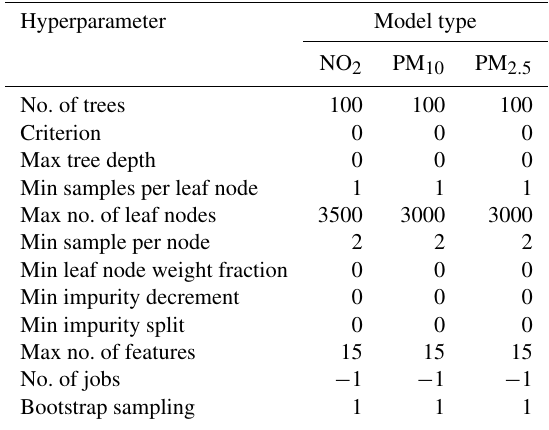
Table 3. Summary of random forest hyperparameter settings used in model